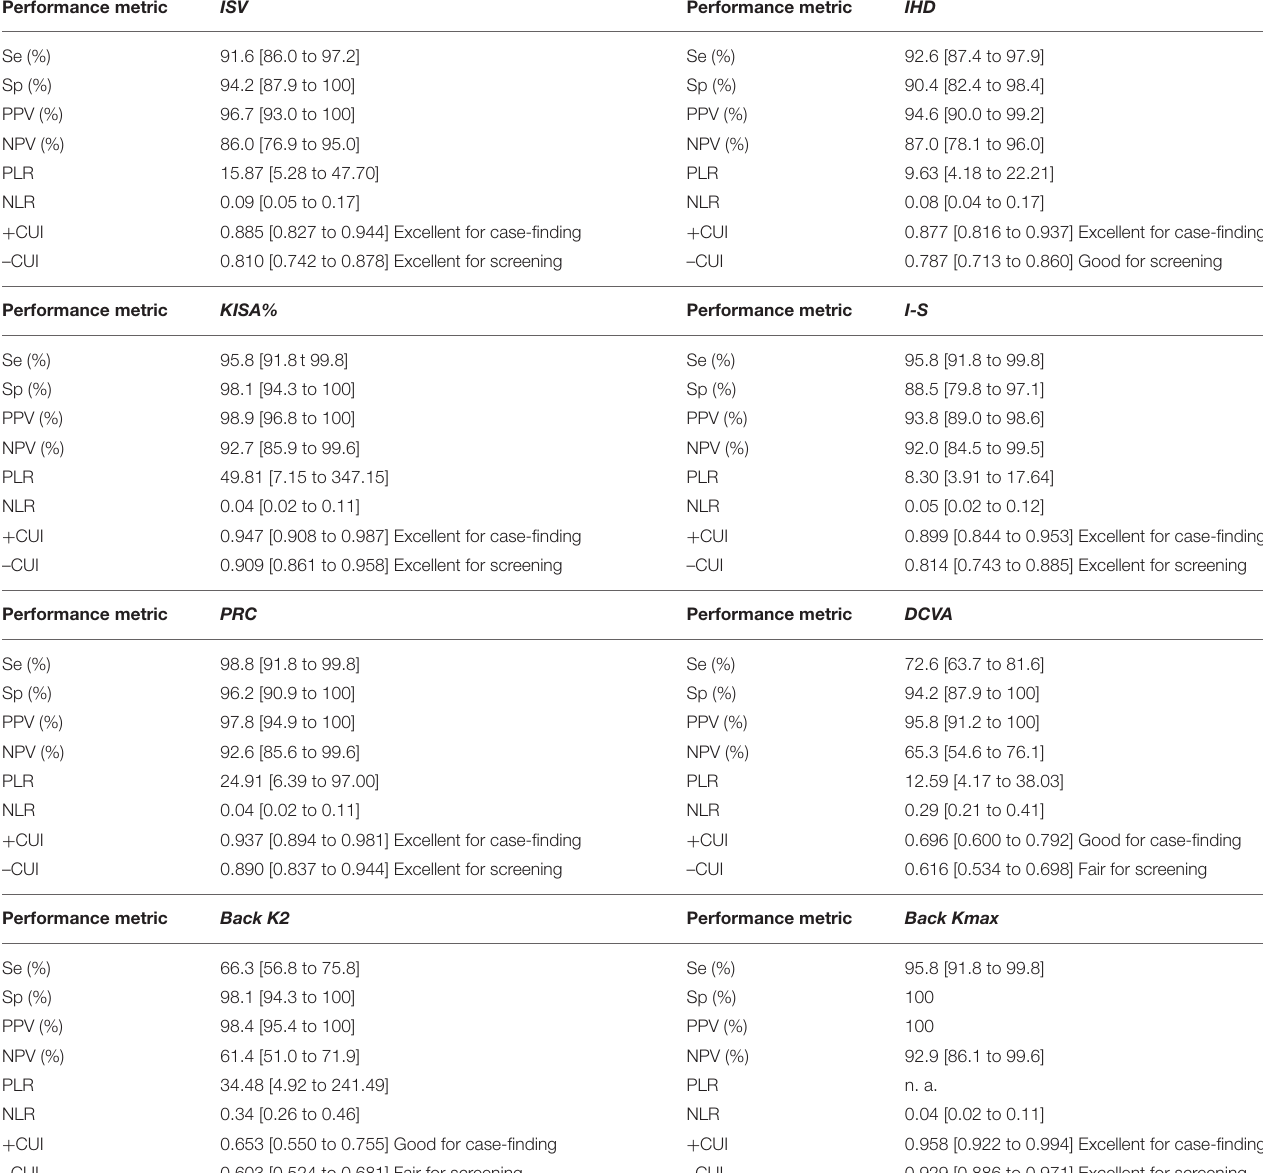
TABLE 9 | Performance analysis of Pentacam indices as diagnosis tools: KCN vs. Skcn. Performance